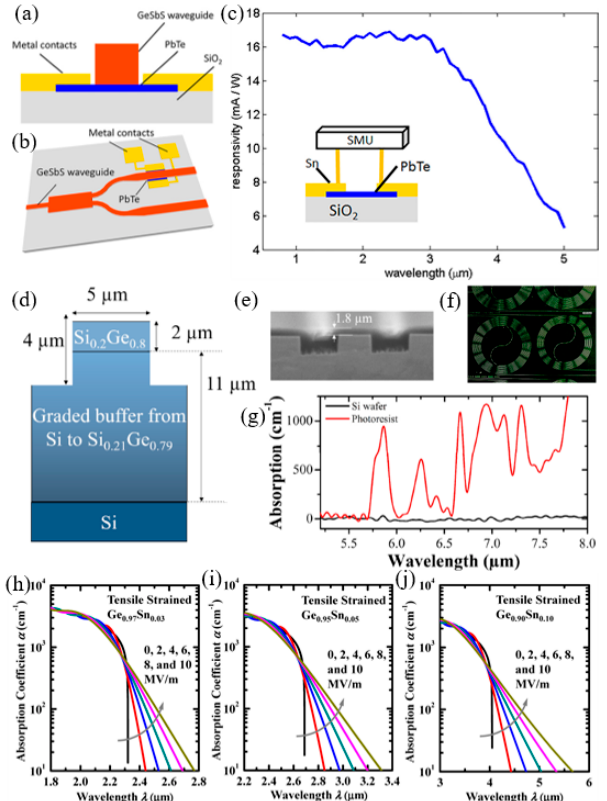
Figure 21. ( a ) Diagram of the cross-section of the integrated MIR detector. ( b ) Schematic diagram of the chip in the device. ( c ) The response of sample 1 at different wavelengths at 213 K with bias voltage of 10 V [307]. Copyright 2016 American Institute of Physics. ( d ) Schematic cross-section of the waveguide considered. ( e ) SEM image of the waveguides covered by S1818 photoresist. ( f ) Top view of the resulting sample. ( g ) Absorption coefficient of the photoresist [308]. Copyright 2018 The Optical Society. ( h – j ) Amplitude and wavelength diagrams of Ge 0.97 Sn 0.03 , Ge 0.95 Sn 0.05 and 2015 The Optical